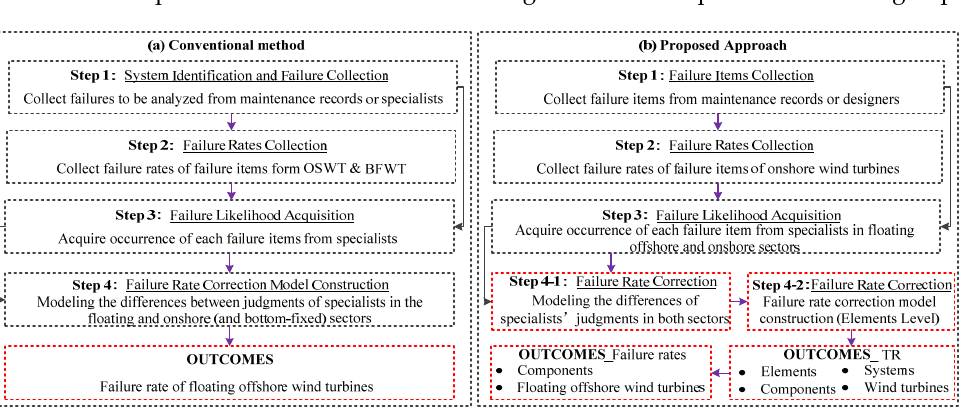
Figure 13. The framework of the proposed failure rate correction approach/conventional method is referenced from [33]. OSWT: onshore wind turbine; BFWT: bottom-fixed wind turbine; TR: transformation factor. Table 11. The rating guidance of occurrence [10, 12, 33].